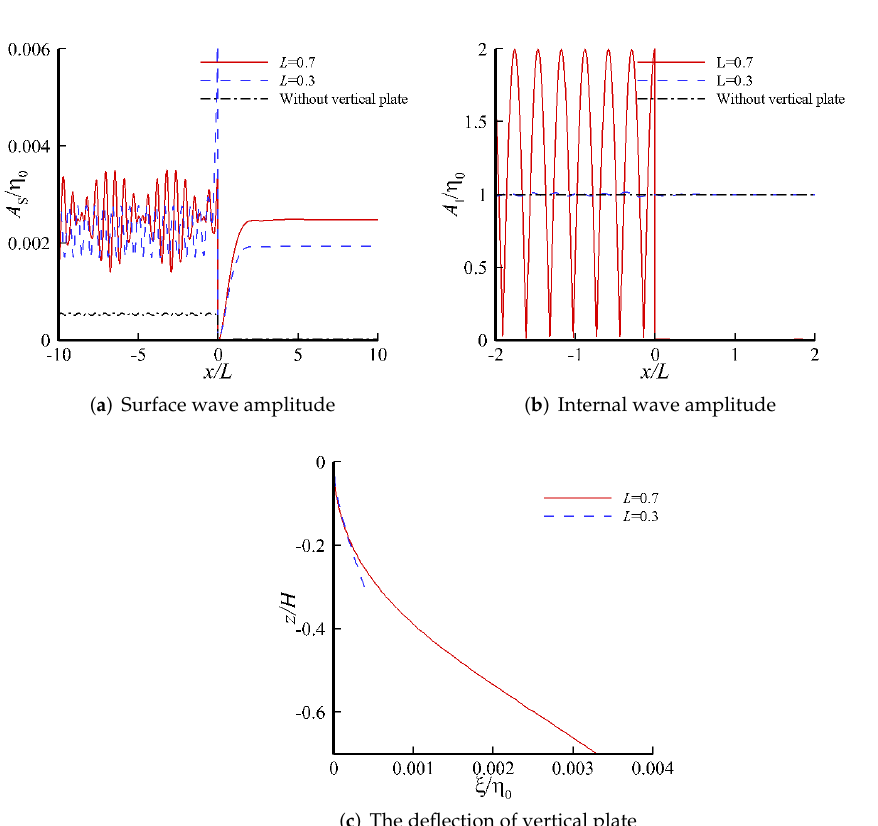
Figure 15. Wave amplitudes A S ( x ) , A I ( x ) , and deflection of vertical plate ξ ( z ) for the different length of a vertical plate L in the case of the incident waves of the interfacial wave